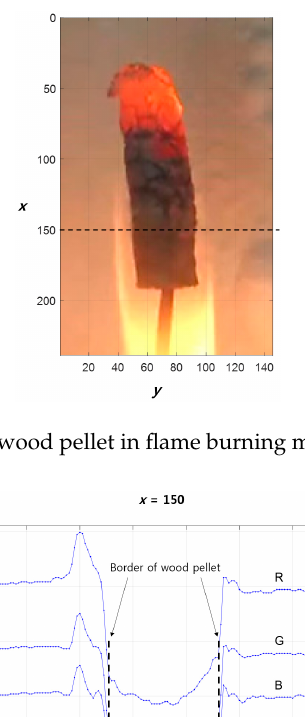
Figure 4. RGB data of image file of wood pellet (Figure 1) along y pixel at x = 252.